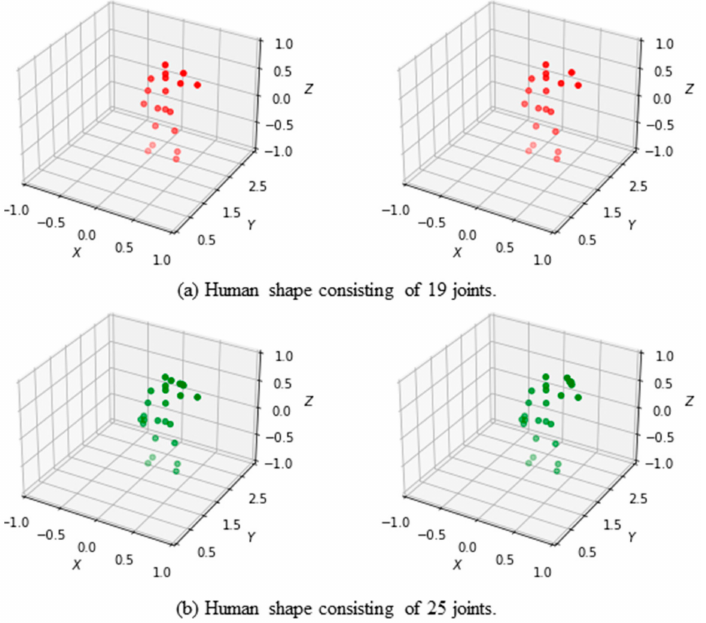
Figure 4. Examples of human joint graphs during left upper limb extension on the MARS dataset